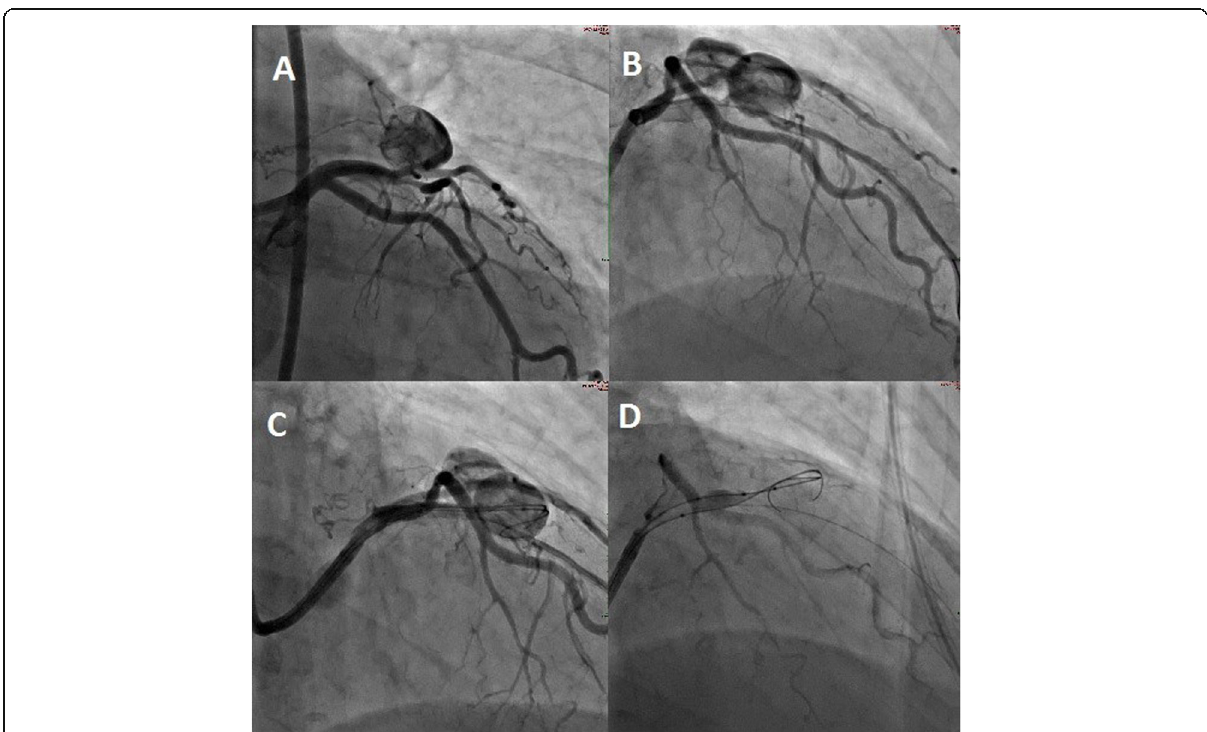
Fig. 3 a and b Initial angiography performed via the 8French Judkins catheter revealed an LADD to pulmonary artery fistula with two large communicated flow related aneurysms. Moderate morphologically significant LADD stenosis was present prior to assessment with an FFR wire. c